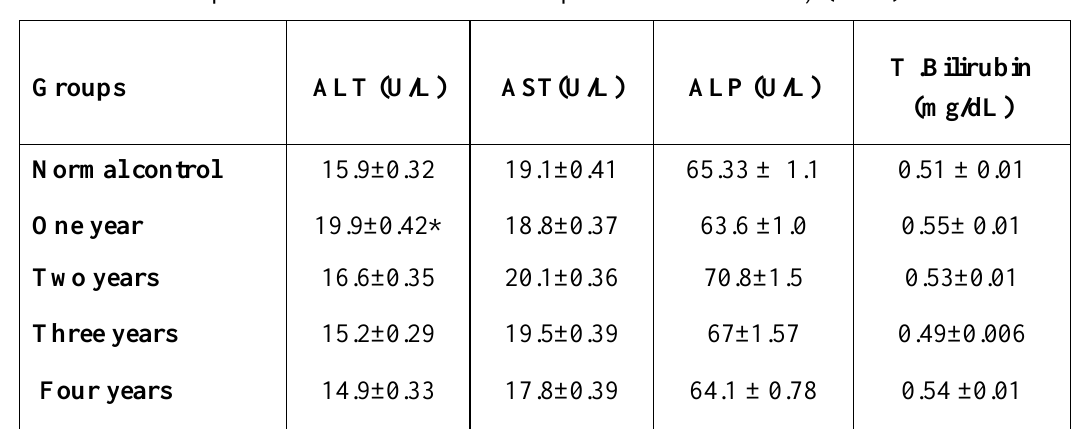
Table 1: Serum liver functions in DMPA users after 1 – 4 years of administration, compared to control. Values are represented as M ± SE,